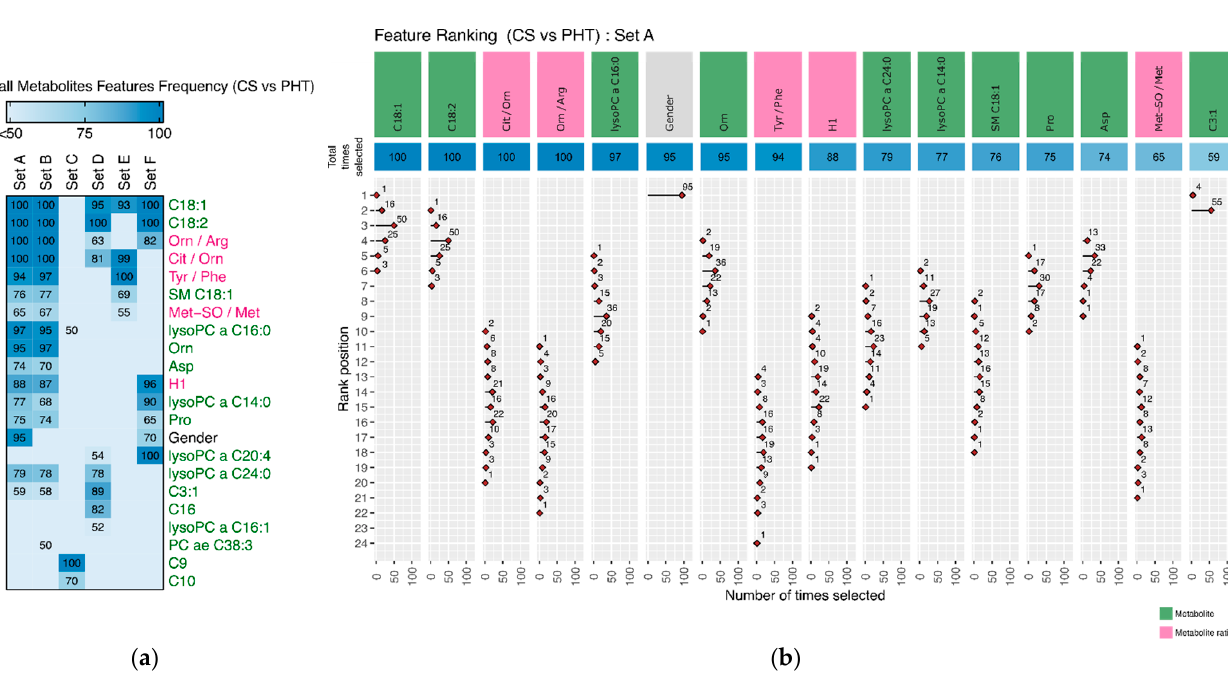
Figure A2. ( a ) Heatmap showing the number of times a feature (metabolites or its ratios) was selected for ALL vs. ALL disease comparison in different sets (A–F); ( b ) Feature ranking for Set A in ALL vs. ALL disease comparison.